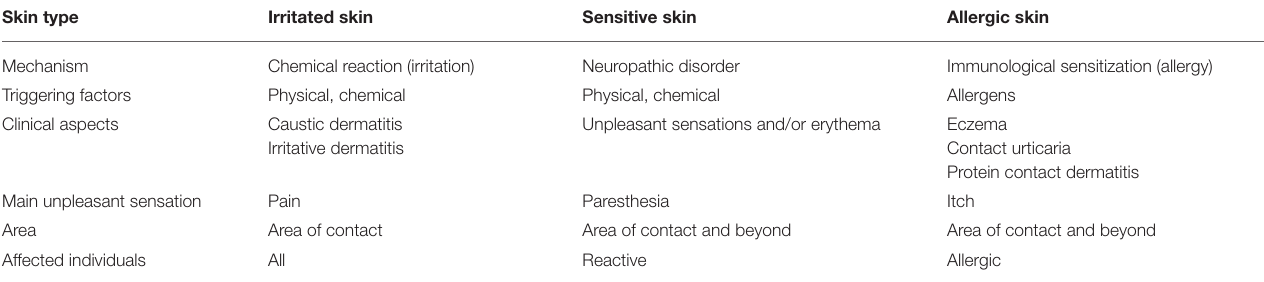
TABLE 1 | Differences among sensitive, irritated and sensitized/allergic